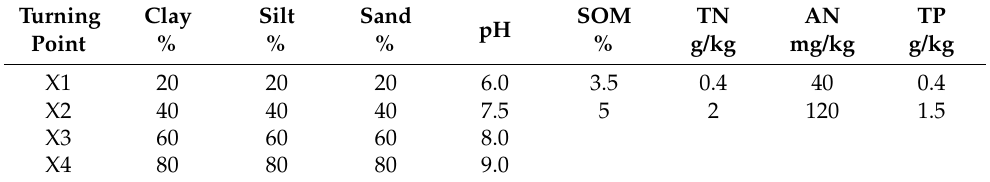
Table 1. The turning points of membership function of soil fertility indexes.